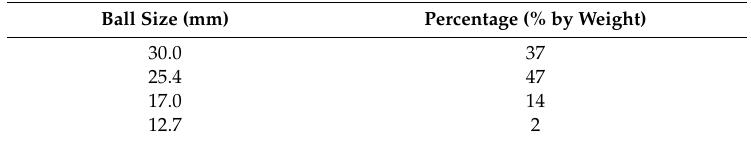
Table 2. Ball size distribution used in both batch grinding and continuous grinding experiments.